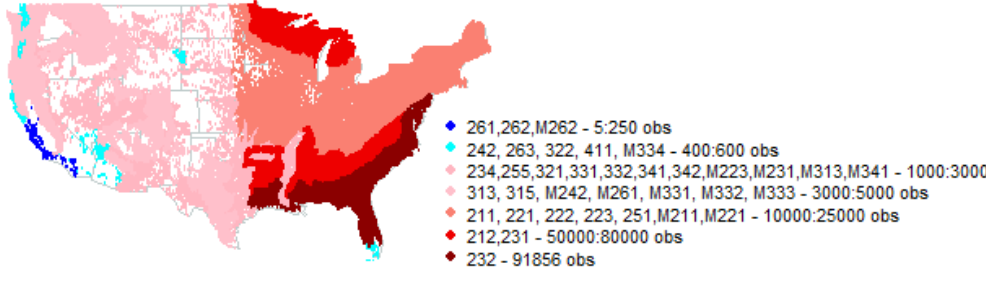
Figure 2. Plot observation frequency map. Ecoregions are grouped by the number of observations. For example, 91,856 forest inventory records were done in the ecoregion